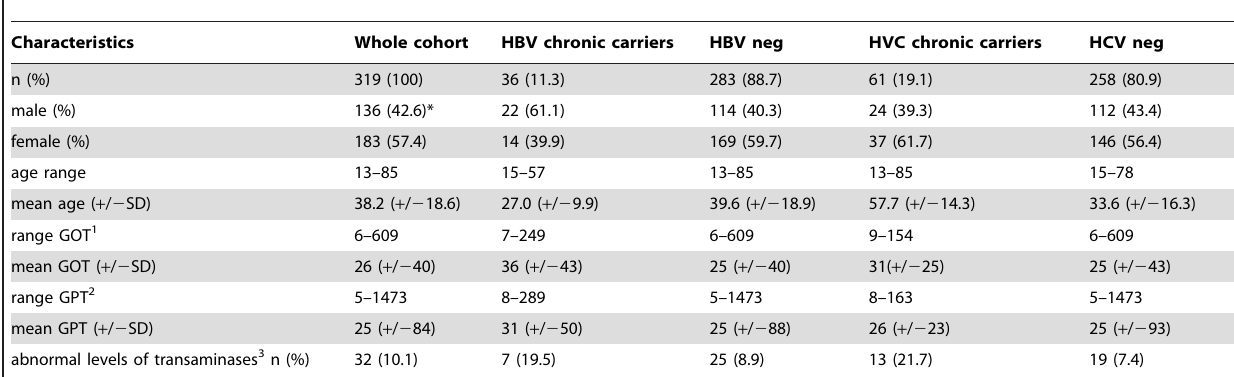
Table 1. Characteristics of the whole cohort and of participants according to HBV and HCV serostatus.